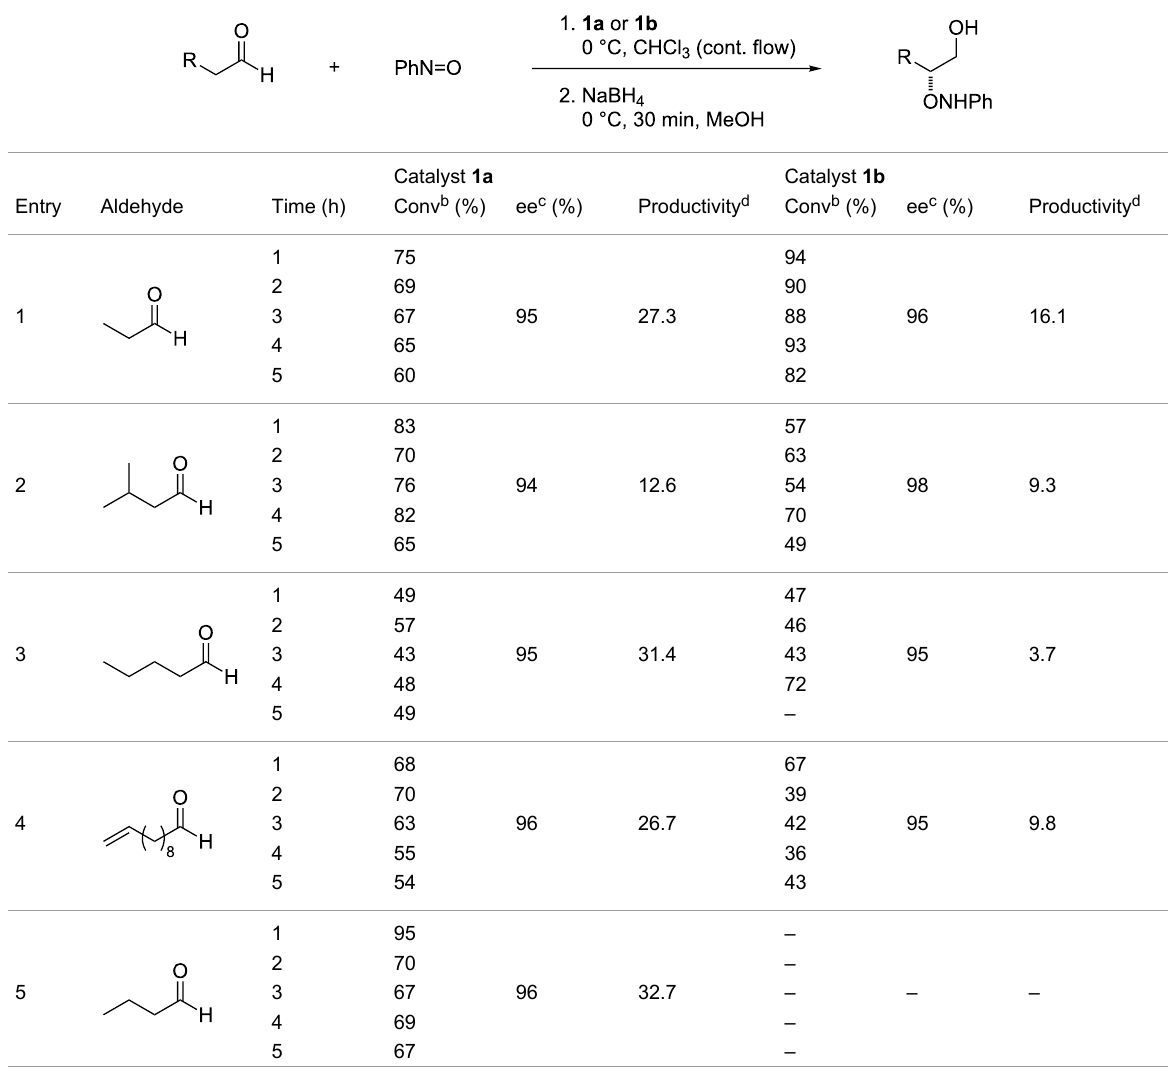
Table 1: Continuous-flow, direct, enantioselective α -aminoxylation of various aldehydes with immobilized catalysts 1a and 1b .